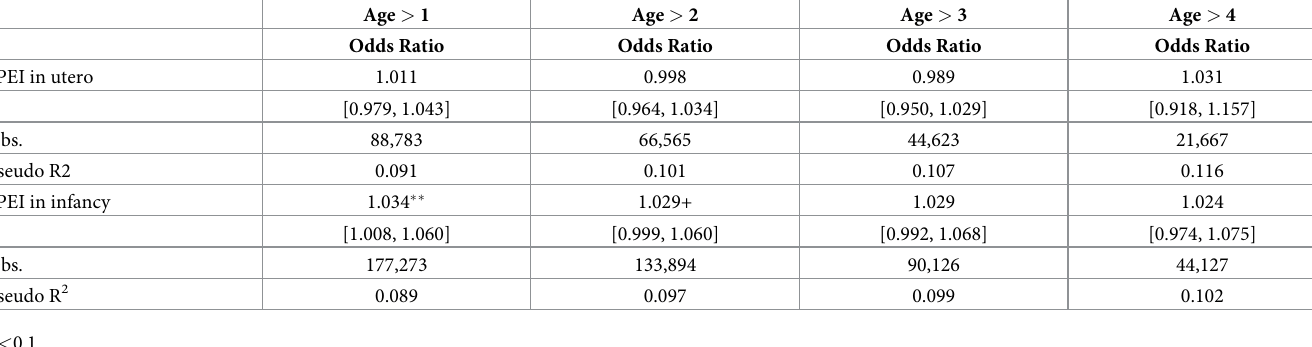
Table 8. Effects of monsoon season SPEI on the risk of stunting by age at measurement. Age >